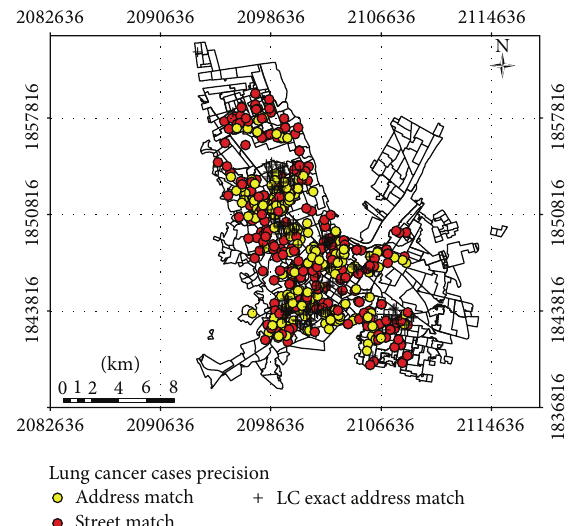
Figure 6: LC death’s address verification in Chihuahua City. The verified addresses are shown by the “+” symbol ( 𝑛 = 171 ); the home address that has a problem with some information is indicated in yellow and red circles ( 𝑛 = 139 and 𝑛 = 368